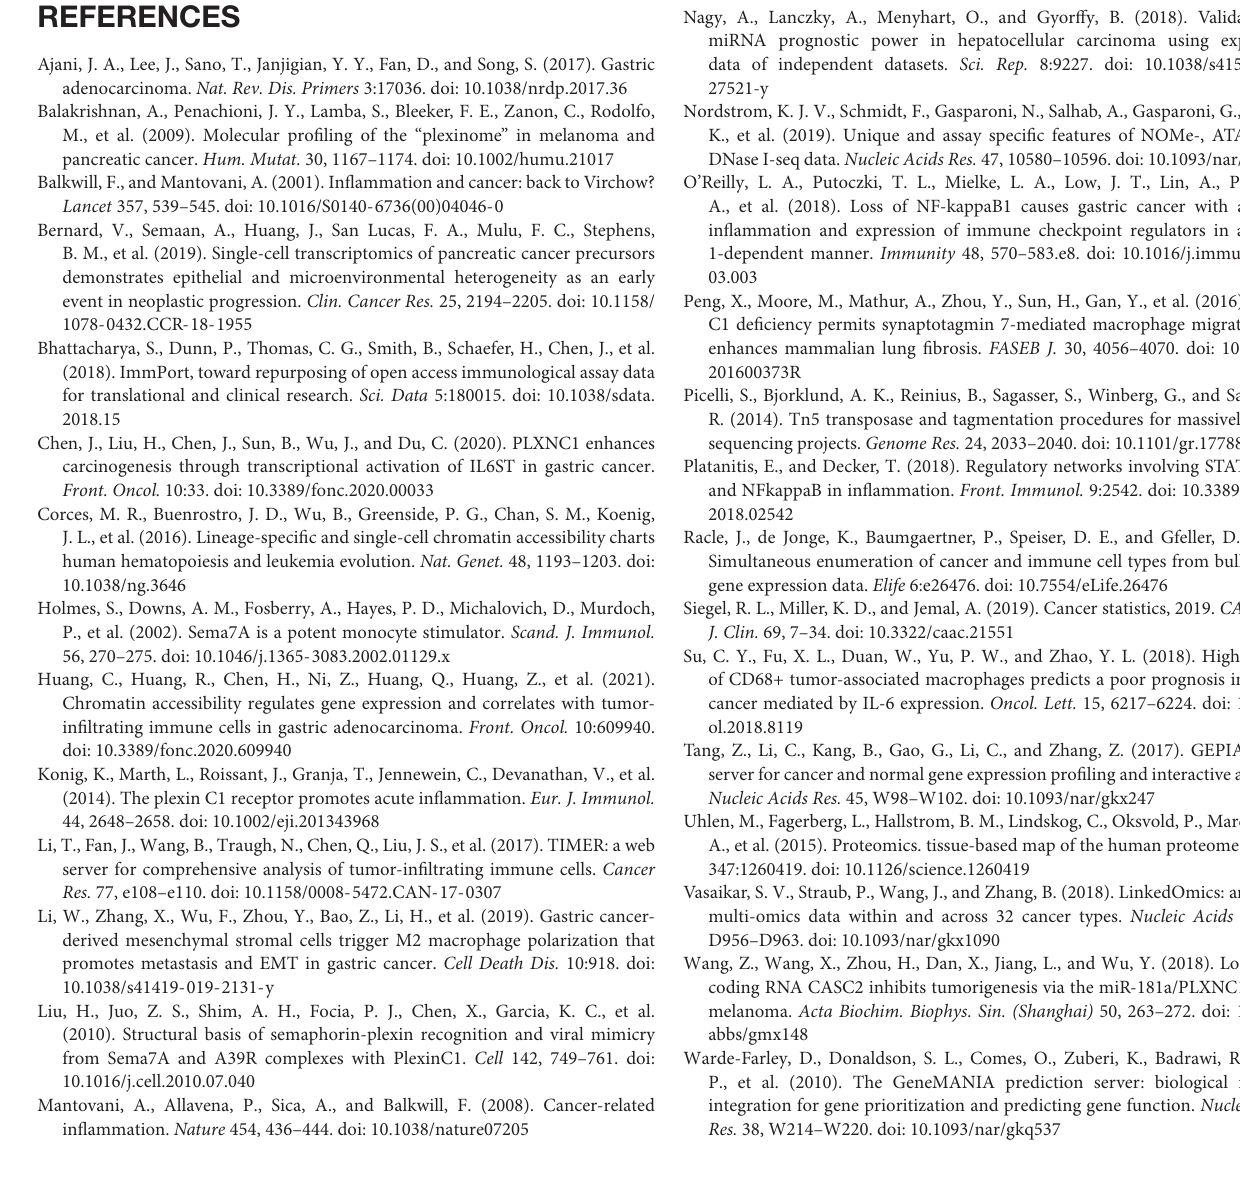
Supplementary Table 2 | The result of 4,287 genes with chromatin accessibility after removing duplicate genes. Supplementary Table 3 | The result of 2,454 genes with chromatin accessibility in promoter regions. Supplementary Table 4 | The result of DEGs with chromatin accessibility. Supplementary Table 5 | A list of 2,498 immune-related genes. Supplementary Table 6 | The results of CIBERSORTx in STAD.